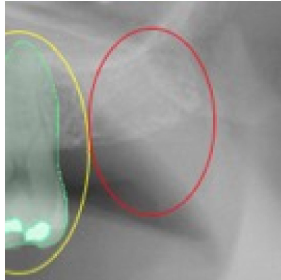
Figure 4. This selected view of Figure 1 shows the incorrect detection in the right position of the tooth 2.7. The assigned value was FP.